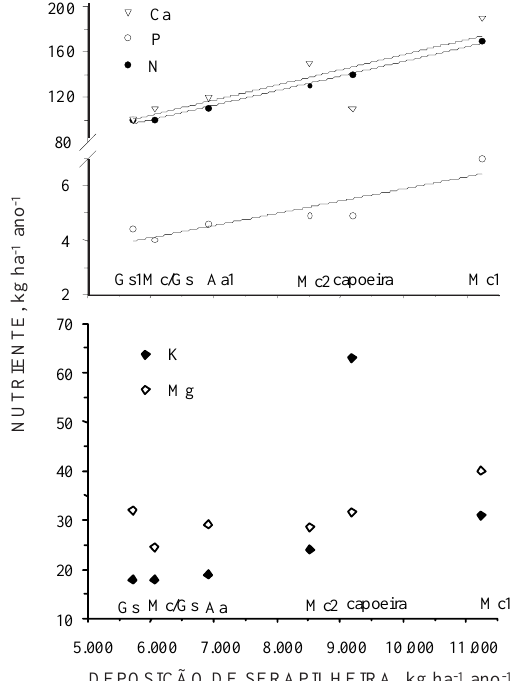
Figura 7. Quantidade de nutrientes depositados anualmente de acordo com a serapilheira produzida. Equações ajustadas para: N, y = 22,48 + 0,129x (p < 0,0001 R 2 = 0,99); P, y = 1,40 + 0,0005x (p = 0,00135 R 2 = 0,82); Ca, y = 23,15 + 0,135x (p = 0,0402 R 2 = 0,69); K, y = 3,05 + 0,0025x (p = 0,0008 R 2 = 0,98), excluindo a capoeira; Mg, y = 8,50 + 0,0027x (p = 0,018 R 2 = 0,88), excluindo a faixa